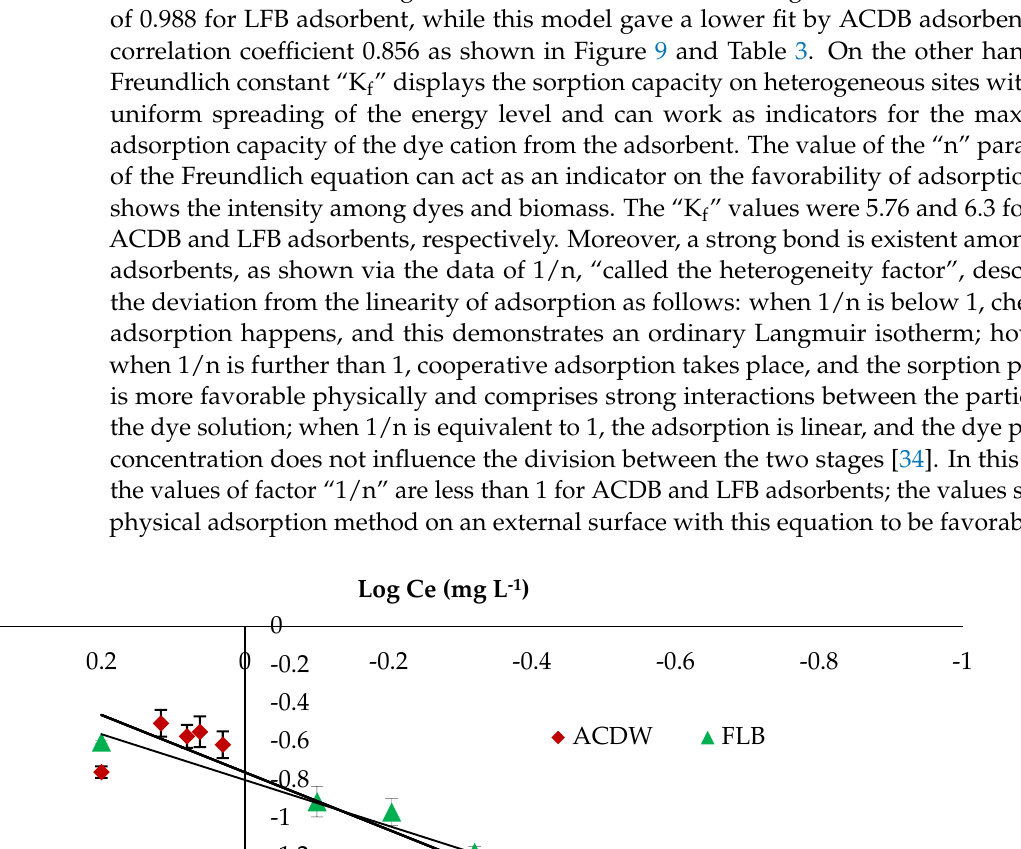
Figure 9. Freundlich isotherm plot for removal efficiency of IV2R dye. Tempkin isotherm shows the influence of some indirect interactions between adsorbate molecules and suggests a linear reduction in the heat of the sorption process of the particles in each layer, owing to these interactions [61]. The value of the regression coefficient (R2+) was found to be 0.67 and 0.881 for both ACDB and LFB adsorbents, respectively (Figure 10), which indicate that this model is not favorable for the removal of IV2R dye. The Tempkin constants A and B were presented in Table 3.